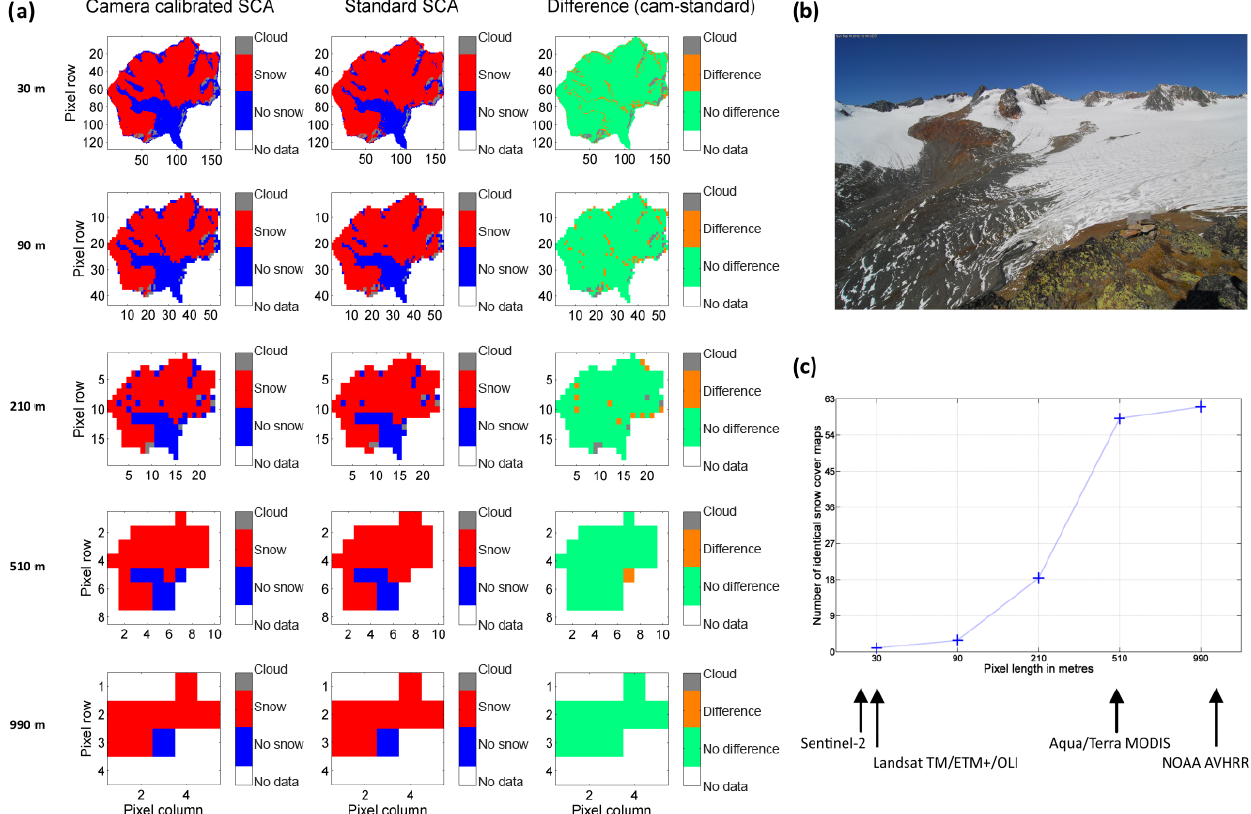
Figure 10. At VF, we exemplarily show in (a) the effect of scaling to NDSI-based snow cover products for a Landsat 7 scene on 16 Septem- ber 2012. The columns from left to right are the camera-calibrated SCA, the standard threshold SCA, and their differences at VF. The different rows show different scaling factors, being 1 (30m) 3 (90m), 7 (210m), 17 (510m) and 33 (990m) from the top to the bottom. The concurrent photograph in (b) depicts the snow situation at VF in our example. The analysis of all investigation dates in (c) shows at which pixel size how many of the camera-calibrated and standard threshold snow cover maps become identical. The spatial resolutions of the Sentinel-2, Landsat, MODIS and NOAA AVHRR satellites are outlined for